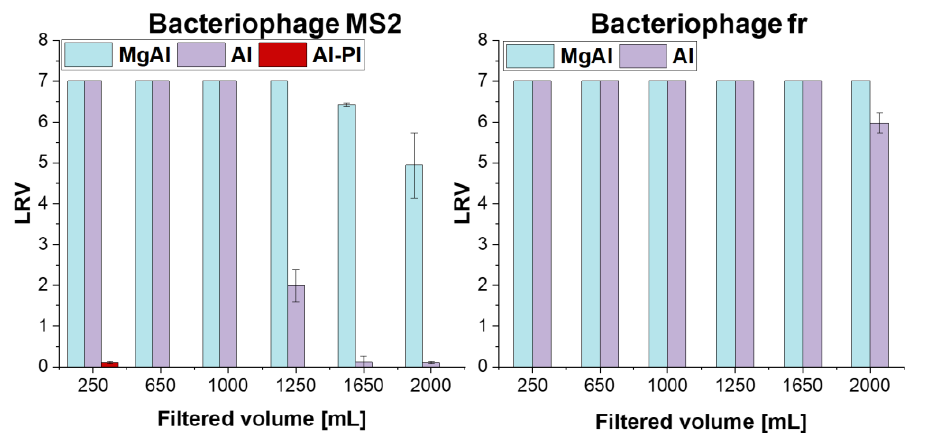
Figure 3. Retention performance of the granules based on MS2 and fr log 10 removal as a function of filtered volume. All filter media contained the same amount of material (4 g).